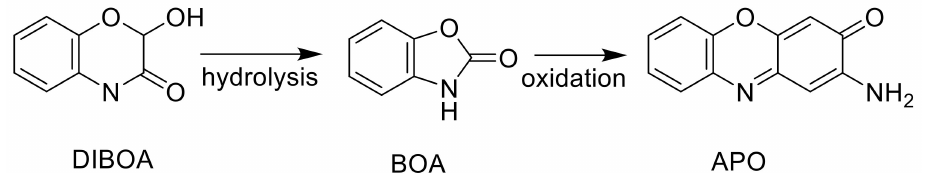
Figure 6. Conversion of the relatively weak and unstable allelochemical (DIBOA) to a strong, more stable phytotoxin (APO) that occurs in